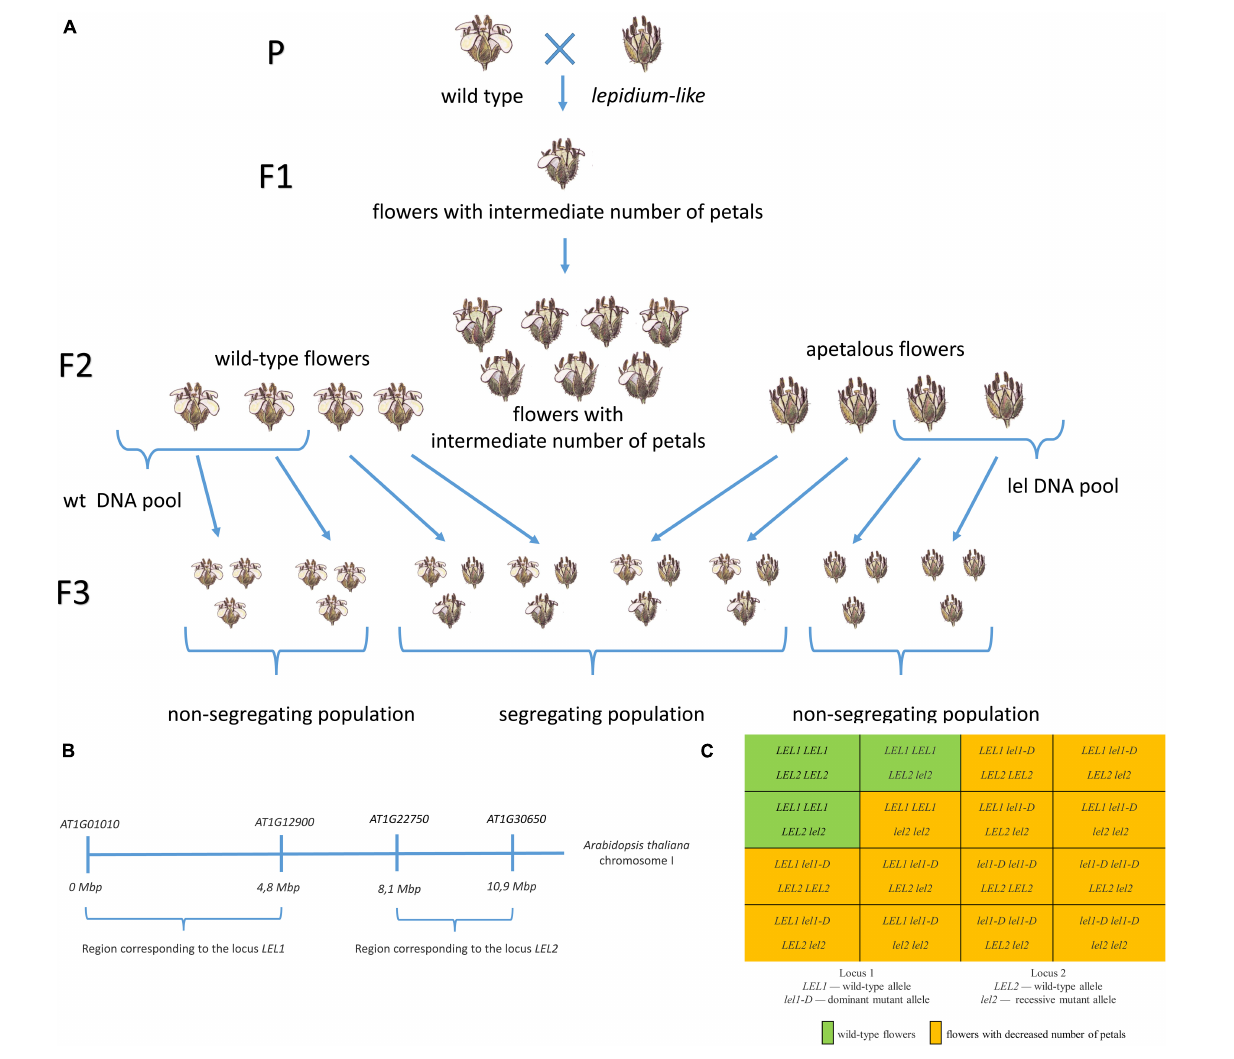
FIGURE 4 | The SNP-based identification of loci associated with apetaly in the C. bursa-pastoris genome. (A) The workflow of F 2 pool construction for DNA sequencing. Wild-type and lel plants were crossed to obtain F 1 progeny with intermediate phenotype. The self-cross of F 1 plants resulted in segregating the F 2 population. We selected F 2 plants with wild-type or severe apetalous phenotype and analyzed their F 3 progeny from self-pollination. Leaves of F 2 plants of which F 3 progeny did not show phenotype segregation were used for DNA extraction and sequencing. (B) The region of Arabidopsis thaliana chromosome I with corresponding apetaly-associated loci 1 and 2. (C) The Punnett square for F 2 progeny of wild-type and lel C. bursa-pastoris